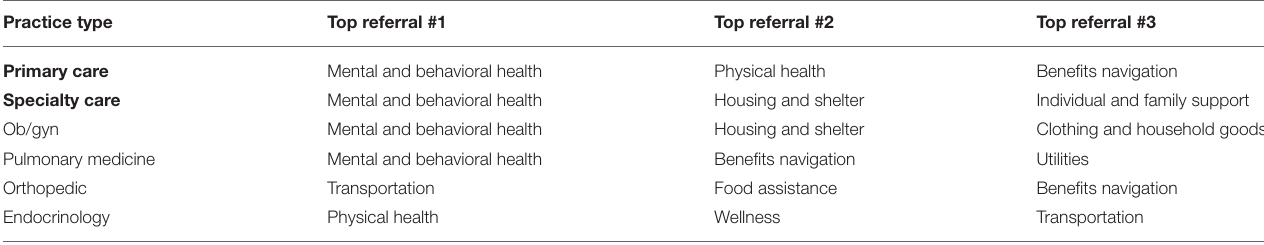
TABLE 2 | The top referral types varied by practice